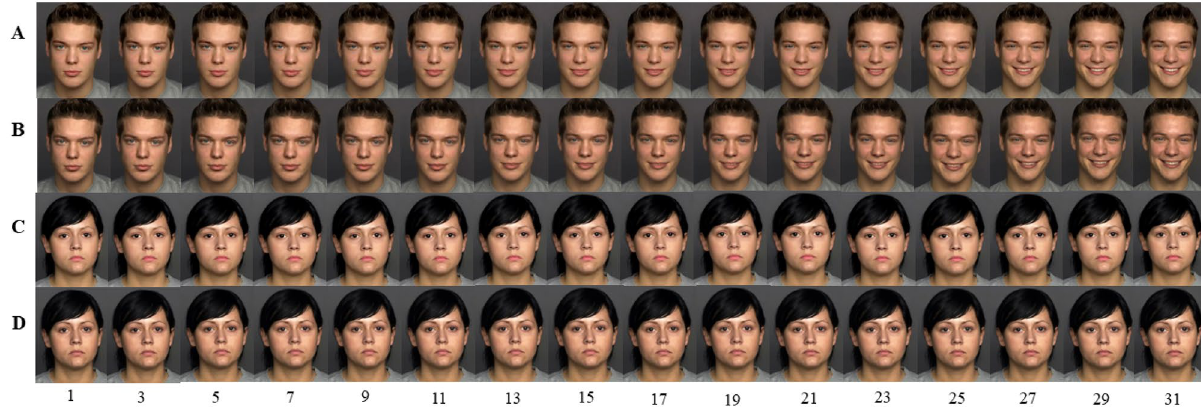
Figure 1. The make-up treatment of emotional videos in Experiment 1. The makeup treatment is shown in Figure. ( A,B ) (happy video) or ( C,D ) (neutral video) were the same emotional videos, ( A,C ) were lightly made up, but ( B,D ) not. The number below indicates the location of this picture in the video (25 frames per second). The original emotional expression video clips were selected from the Dynamic FACES database (No. 066 and No. 140) 42 , and have been permitted to use by its